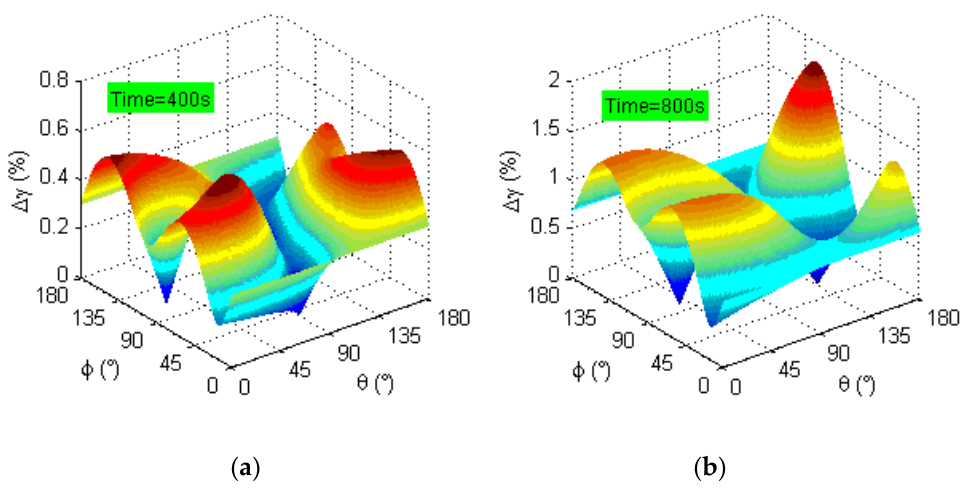
Figure 11. The location of the critical plane: ( a ) time = 400 s; ( b ) time = 800 s.